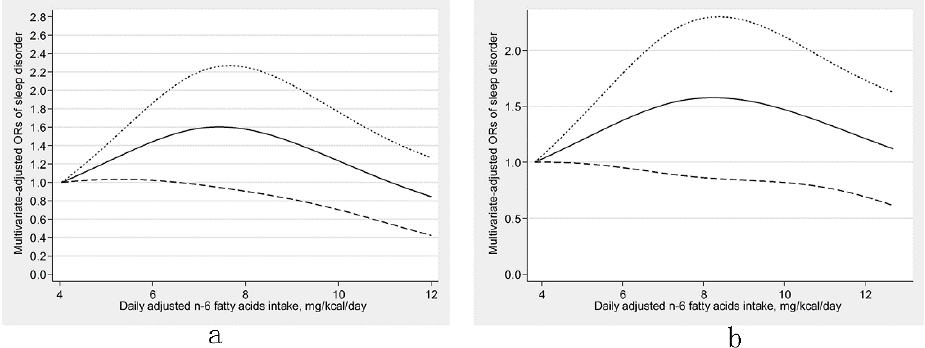
Figure 3. Restricted cubic spline models of the odds ratios (ORs) of sleep disorders with dietary ω-3 fatty acid consumption for men ( a ) and women ( b ). The solid line and dashed lines represent the estimated ORs and the 95% confidence intervals, respectively.